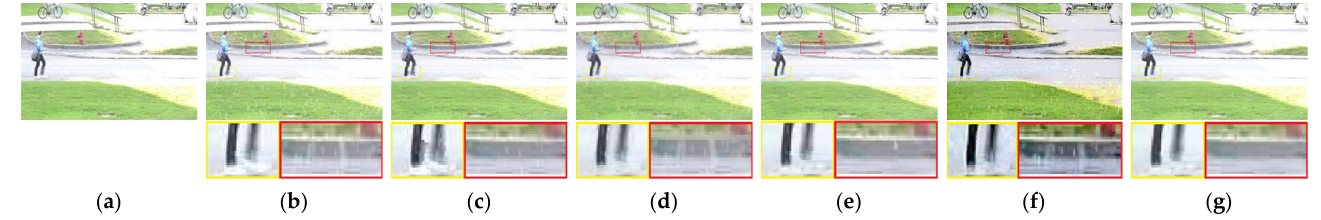
Figure 4. Comparison on a synthetic snow video. ( a ) Ground truth, ( b ) input, ( c ) Kim et al. [16], ( d ) Wang et al. [8], ( e ) Li et al. [14], ( f ) Chen et al. [32], ( g ) proposed method.